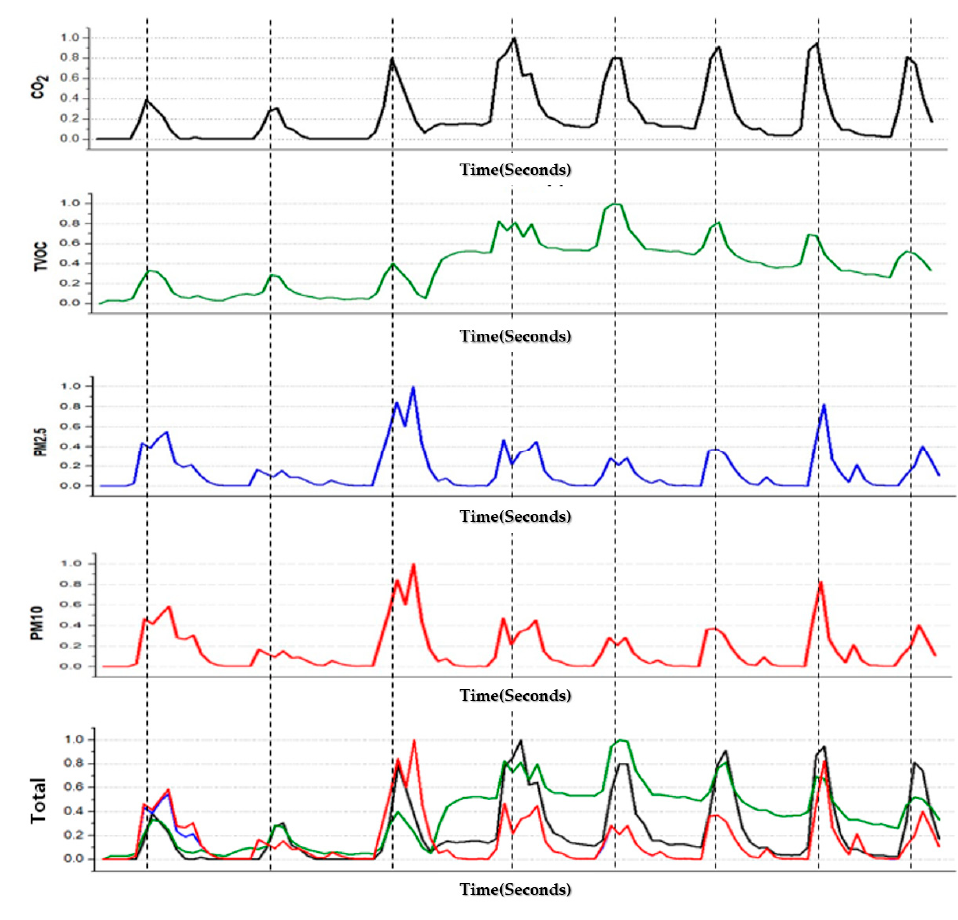
Figure 10. Pre-processed training data.